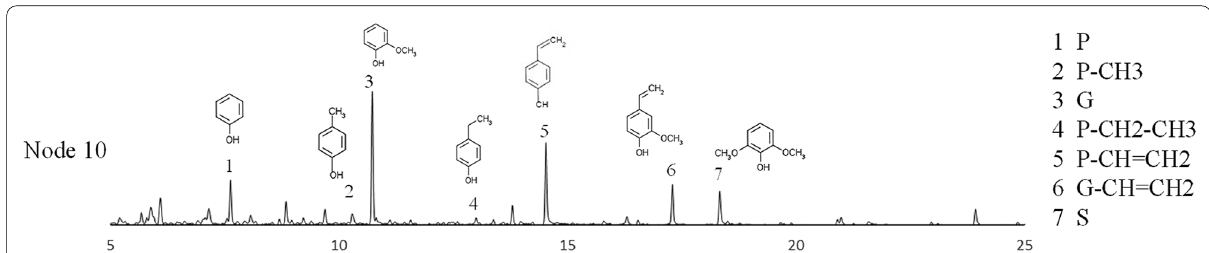
Fig. 7 Results of the Py‑GC analysis of the current year bamboo. Pyrolysis products derived from H‑, G‑, and S‑types identified by Py‑GC analysis of node10 of the current year bamboo